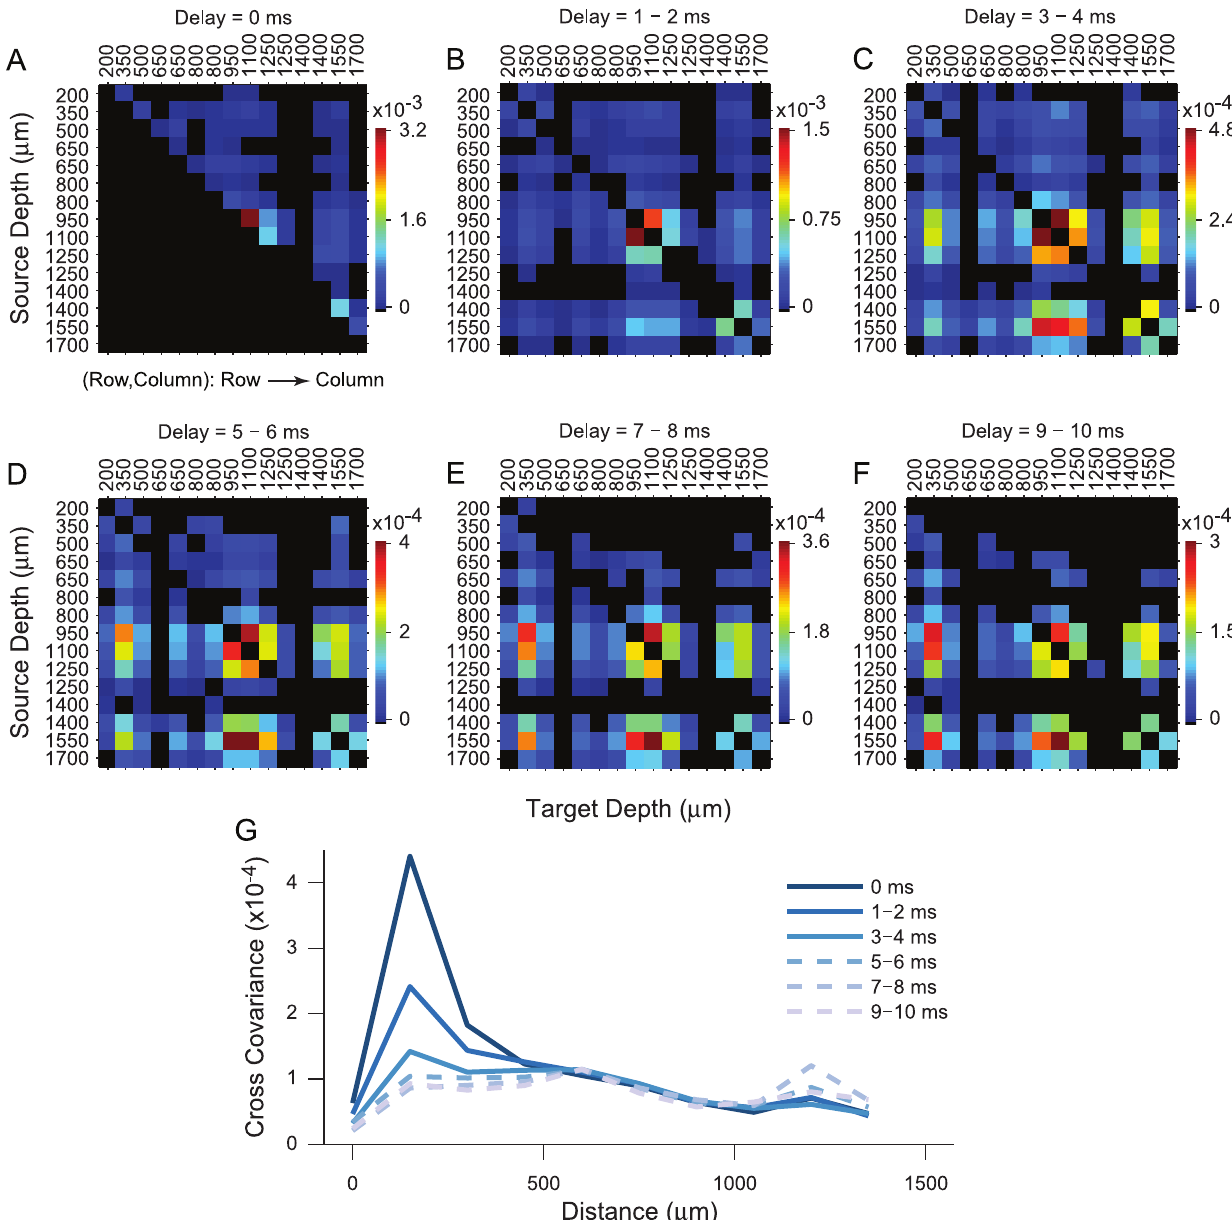
Figure 8. Synchronization Matrices (SMs) for neurons in an AI column. Data from example penetration in Figure 1. (A–F) SMs. Each pixel in an SM represents thestrength of thecross-covariancefunction between the neurons whose positions arelisted aboveandto theleft of theplot (blueto red indicates increasing connection strength). Matrices are ordered so that element (A,B), or (Row, Column), represents the cross-covariance function value consistent with an A to B flow of information. The SM values are obtained by averaging the cross-covariance function values at the delays listed above each plot. The strength of neural synchronization between local neurons decreases for longer delays but stays the same or slightly increases between more distant neuron pairs (increasing SM values at off-diagonal positions). Black pixels indicate cross-covariance function values that did not achieve significance. (G) Cross-covariance function values versus distance between neurons at multiple delays. Data are obtained from the SMs in (A–F). doi:10.1371/journal.pone.0009521.g008 subfields alone (Excitatory – Fig. 12B: r= 0.434, p , 0.01; Inhibitory – Fig. 12C: r= 0.348, p , 0.01, t-test). The correlation between connectivity strength and STRF similarity for the putative monosynaptically connected neuron pairs was not